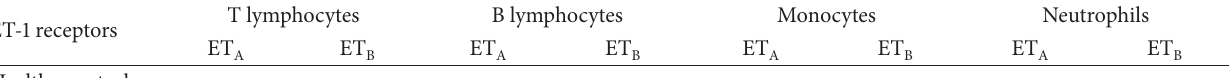
Table 1: ET and ET expression on T and B cells, monocytes, and neutrophils in healthy controls and SSc patients. A B ET-1 receptors Healthy